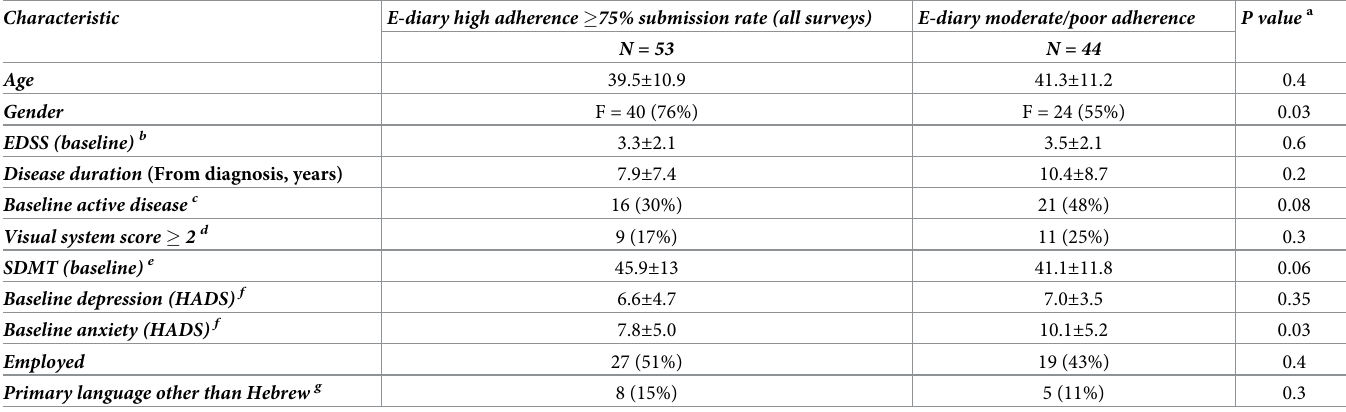
Table 2. Predictors of adherence to patient reported outcomes collection by the e-diary. Characteristic